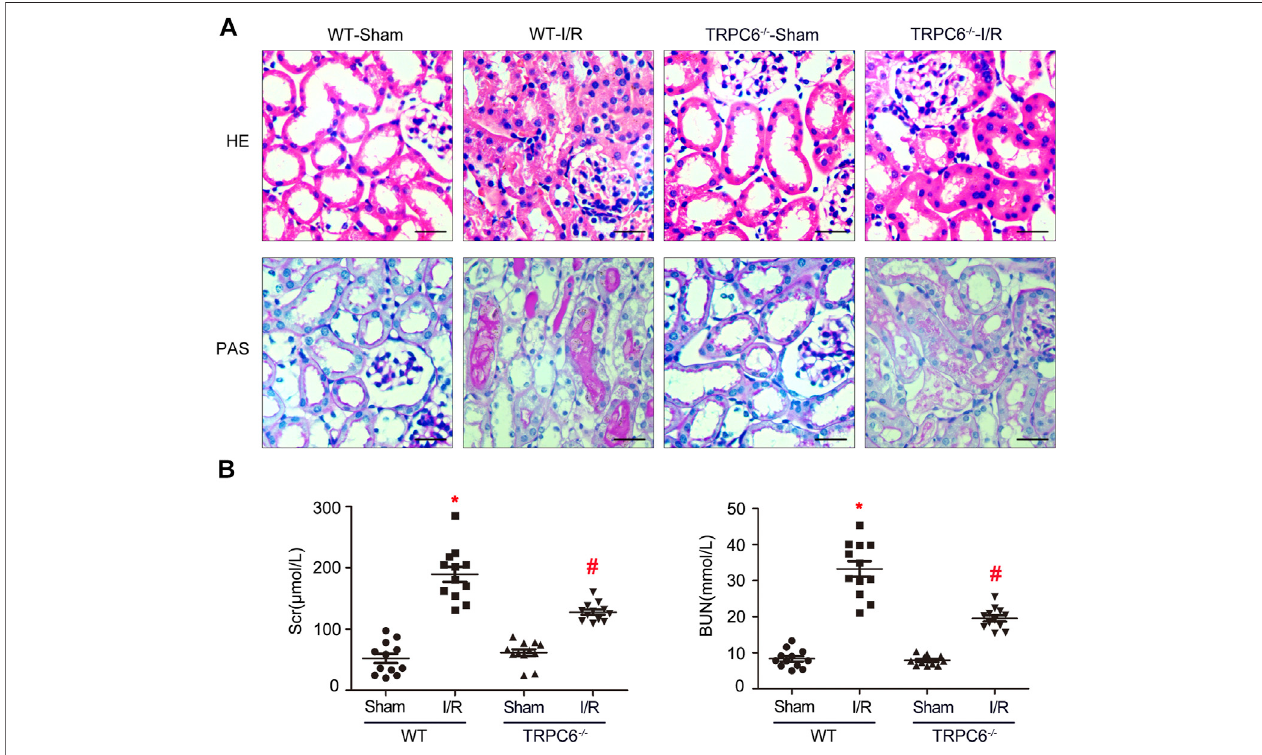
FIGURE 2 | TRPC6 knockout attenuates renal tubular damage upon IRI in vivo . (A) Representative images of kidney tissue section samples of WT and TRPC6 − / −